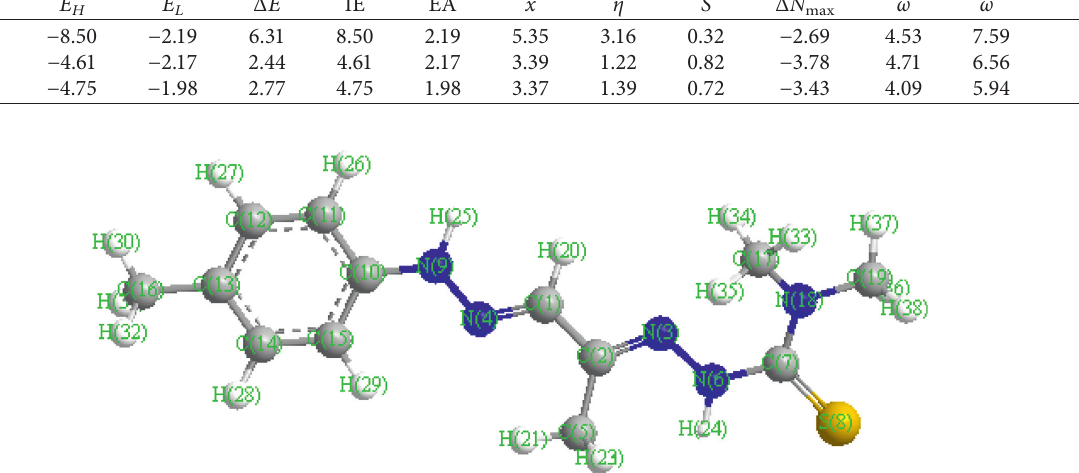
Table 1: The calculated quantum chemical parameters of the DMPTHP ligand and M(II)-DMPTHP complexes. Compound E